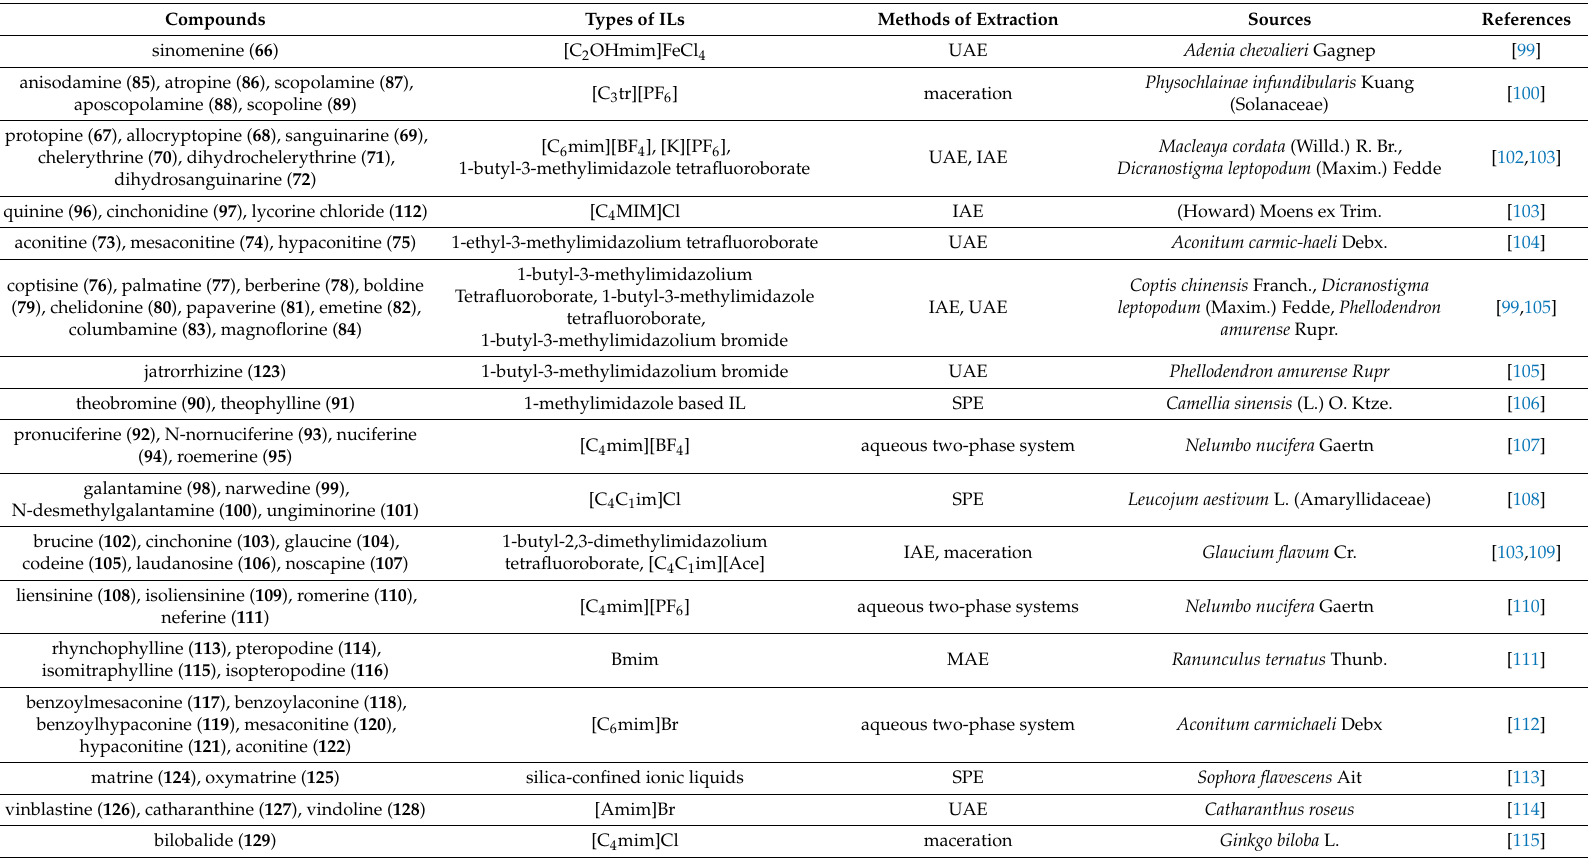
Table 5. The alkaloids extracted from natural sources using ILs or IL solutions by different extraction